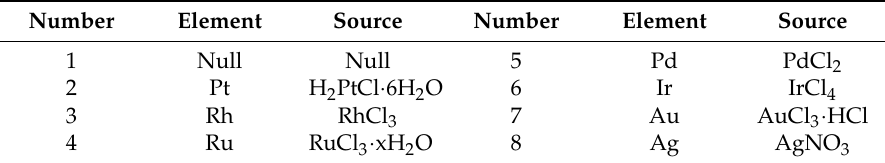
Table 1. The source of additives applied in the surface modification.